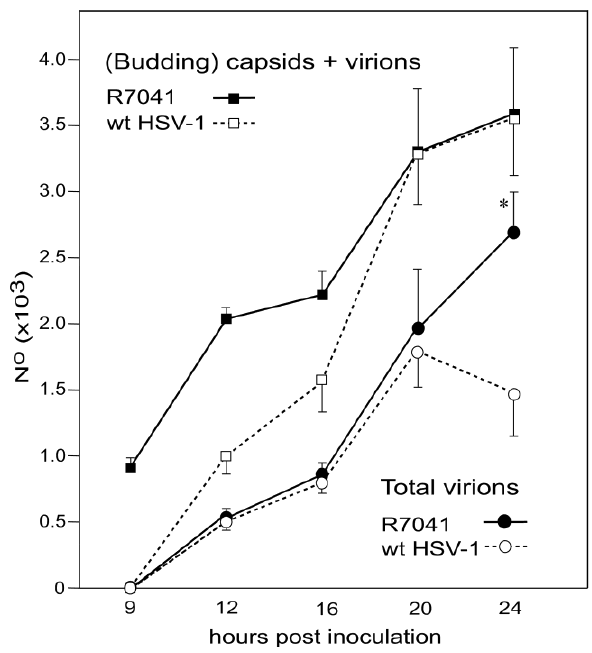
Figure 13. Mean total number and standard deviation of R7041(∆Us3) and wt HSV-1 virus particles (capsids in the cytoplasmic matrix, budding capsids at any membrane as well as virions), and of virions including those in the PNS, RER, Golgi cisternae and/or vacuoles. (* p < 0.001, n =